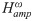
Results of data analysis of human EEG.The frequency ranges analysed i = 1, 2, 3 are 35-40Hz, 60-65Hz and 72-77 Hz respectively, which are displayed as superscripts in the plots. Each point on a plot corresponds to estimates made from one EEG spatially filtered component (SSD), with the colours denoted distinct frequencies. In the left hand panel we display ρDCCA(n) values at the highest scale vs. Hampω values. In the middle panel we display Hampω values between frequencies and in the right hand panel we display Hampω plotted vs. Hraw.